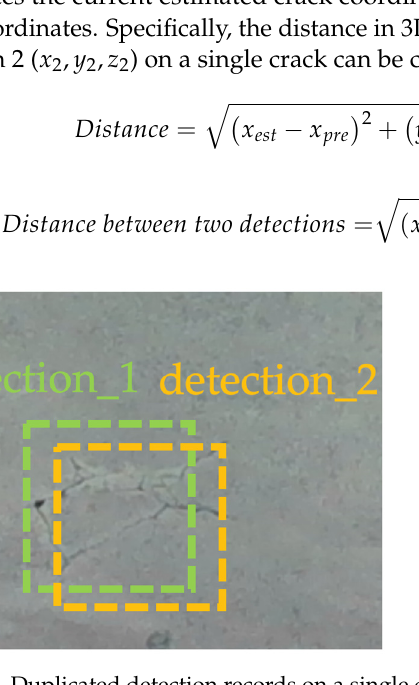
Figure 13. Duplicated detection records on a single crack.